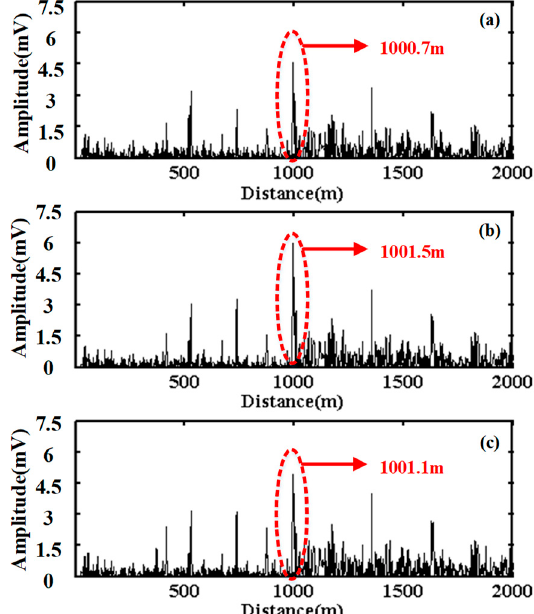
Figure 9. Positioning curves with the curve step of ( a ) 19, ( b ) 20, and ( c ) 21.